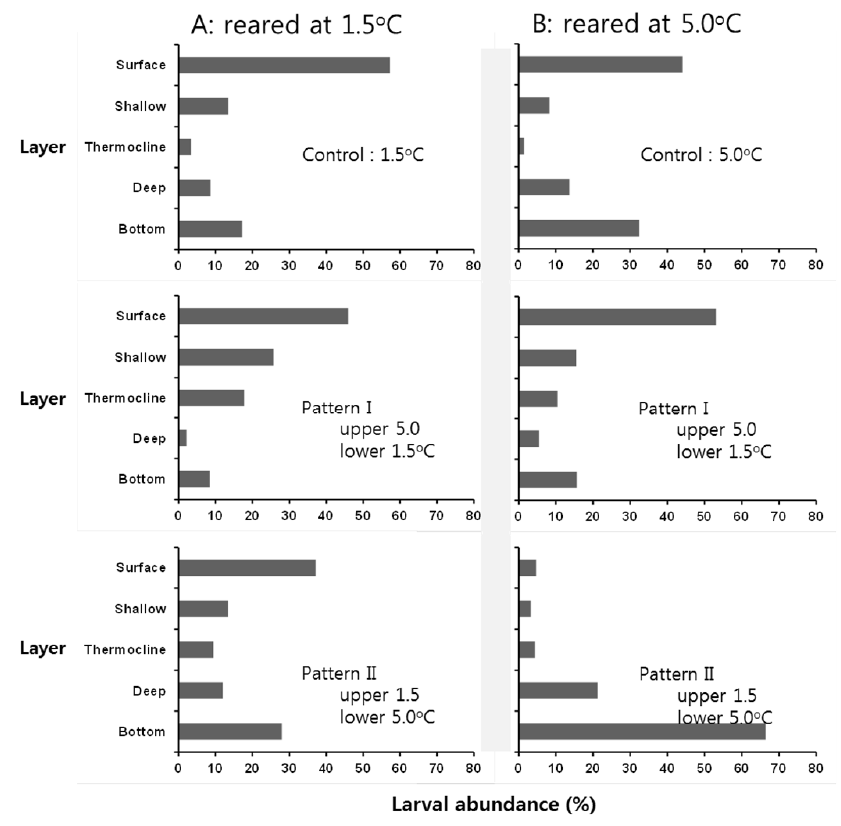
Figure 10. Temporal changes in the vertical distribution of walleye pollock larvae with yolk sac almost completely absorbed. Three thermal vertical patterns were used: Control and Patterns I and II. The size of the open circles reflects the number of larvae seen at each time (h) and depth.